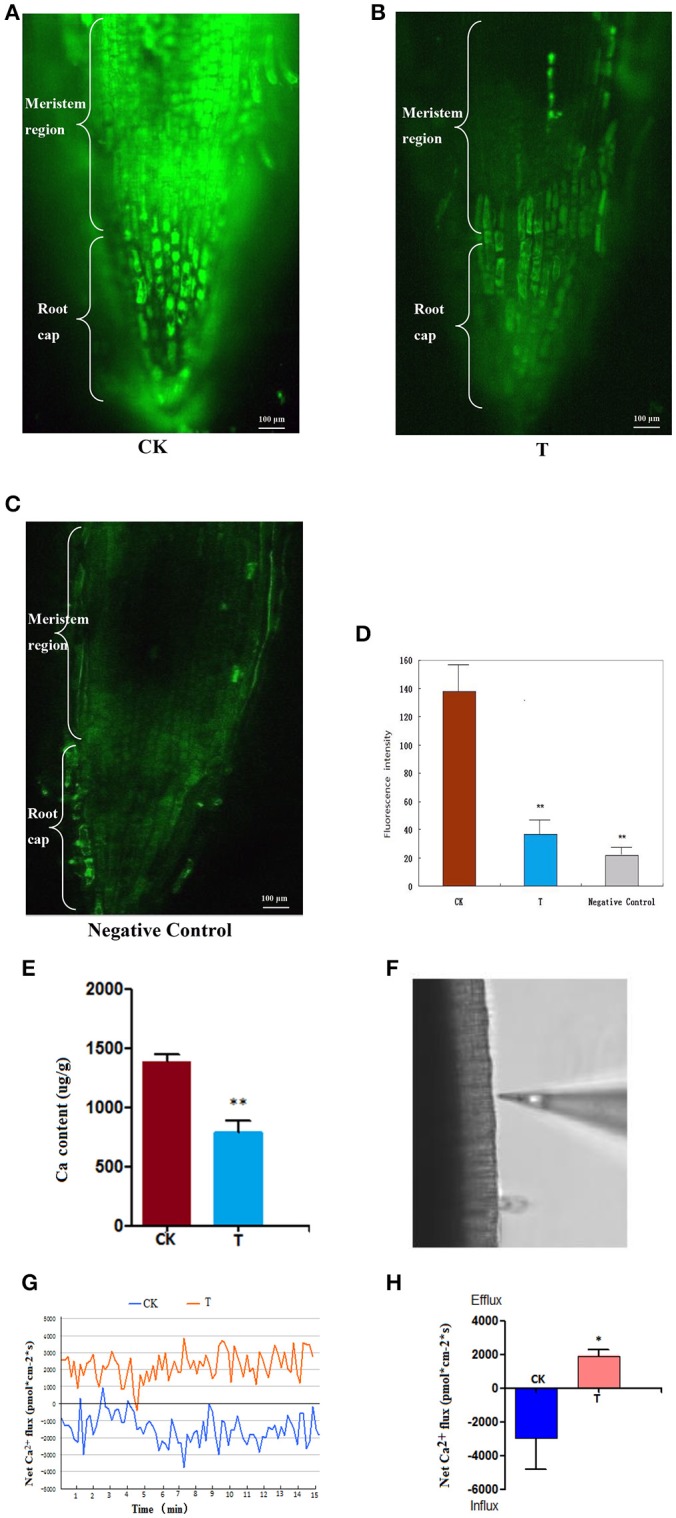
Ca2+ detected using Fluo-3/AM Staining, ICP-MS and NMT. All of the detections and the statistical analyses were performed in three biological replicates. *Significant difference (p < 0.05); **Highly significant difference (p < 0.01). (A) Confocal image of [Ca2+]cyt in CK: the control wheat roots treated with Fluo-3/AM. Scale bar = 100 μm. (B) Confocal image of [Ca2+]cyt in T: the 1.5 LaCl3- treated wheat roots treated with Fluo-3/AM. (C) Confocal image of [Ca2+]cyt in the negative control: the control wheat roots not treated with Fluo-3/AM. (D) The chart showing the statistical results of the fluorescence intensity in meristematic regions. (E) Ca content in wheat measured using ICP-MS. (F) The image shows the measuring position using the Ca2+-selective microelectrode of NMT. (G) The image shows the kinetics of Ca2+ flux in wheat roots of CK and T. (H) A chart showing the statistical results of the net Ca2+ flux in meristematic regions at 24 h.